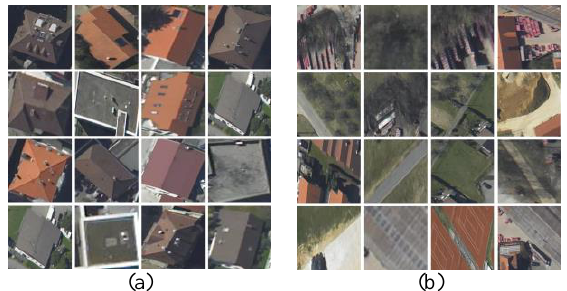
Figure 3. Training data for the building detection including